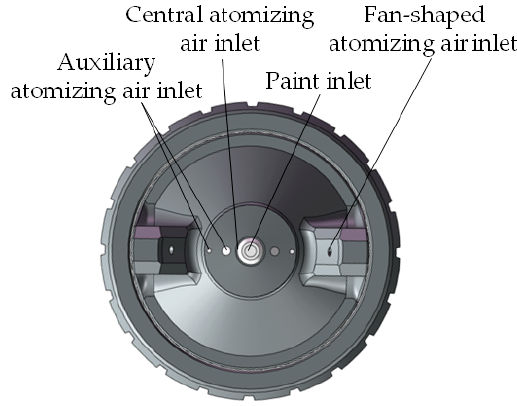
Figure 2. Three-dimensional model of the air cap.